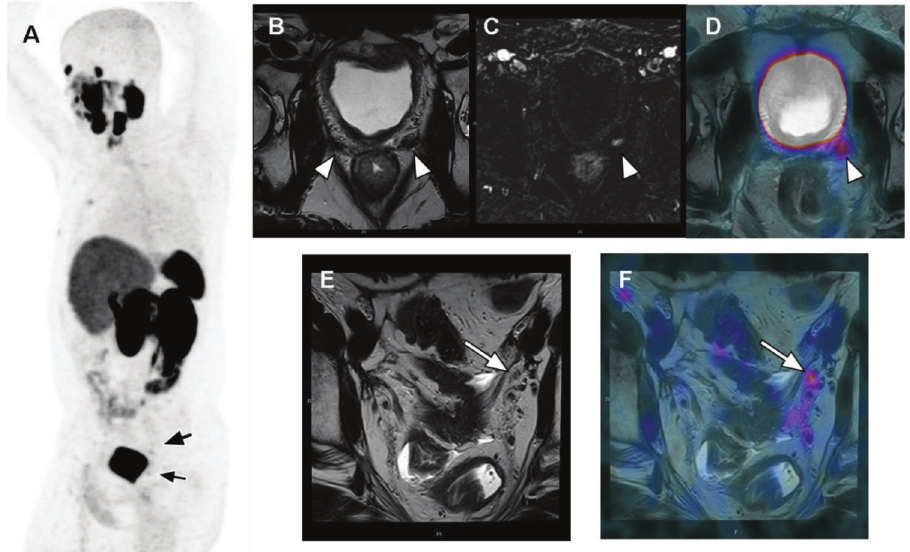
Figure 2 - Evaluation of BCR in a 68-year-old patient treated with prostatectomy with a Gleason 7 adenocarcinoma (8 years) and prostate bed radiation (3 years), with a current PSA level of 0.29 ng/ml. 68 Ga-PSMA-fused PET/MRI MIP images (A) demonstrated 2 pathologic areas of focal uptake in the pelvis (black arrows). Axial T2-weighted imaging (B) showed nonspecific bilateral hypointense tissue in the prostate bed (arrowheads); however, T1-weighted perfusion imaging (C) demonstrated hypervascularity in the left tissue (arrowhead), which also had focal PSMA uptake on fused PET/MR imaging (D), confirming local recurrence. Moreover, a 4-mm left external iliac lymph node (white arrow) was almost not visible on axial T2-weighted imaging (E) but had focal uptake on fused imaging (F), which was very suspicious for pelvic nodal